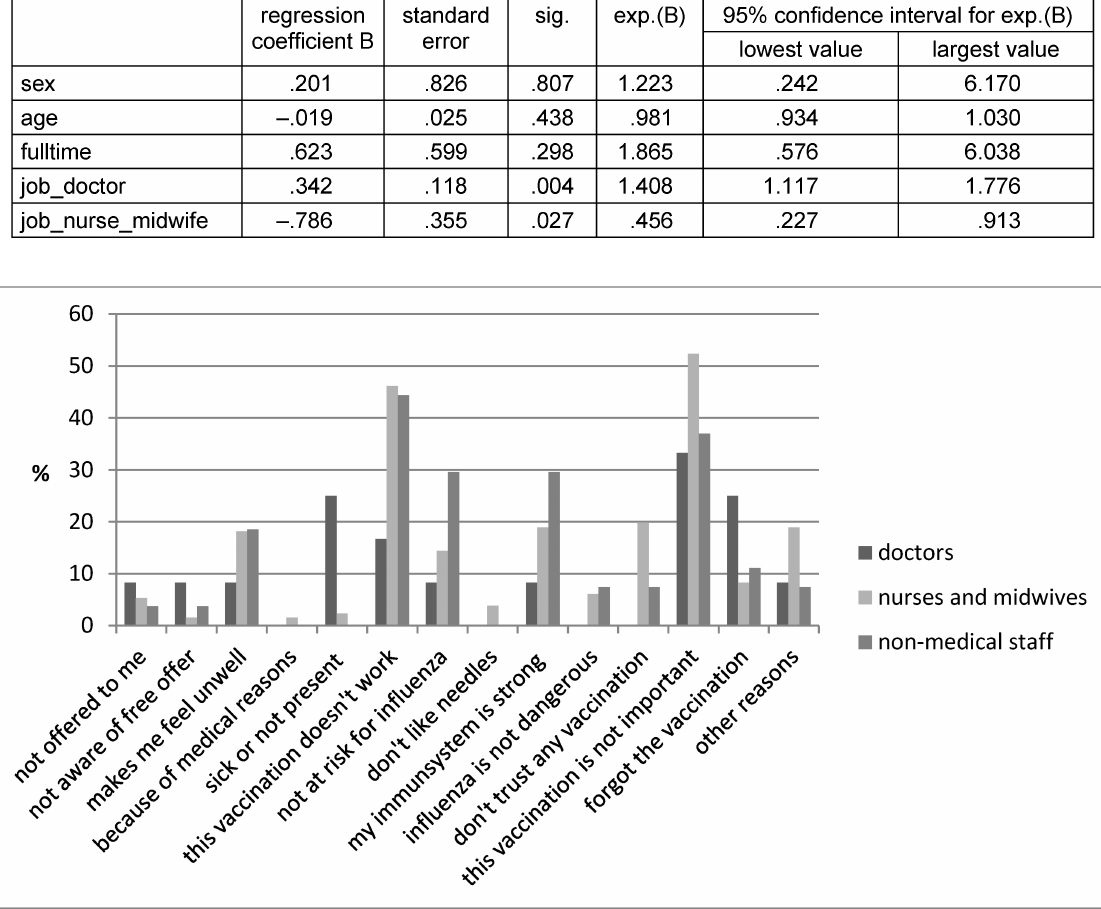
Figure 2: Not vaccinated healthcare workers: reported reasons for choosing not to be vaccinated (171 staff members responded to the question)